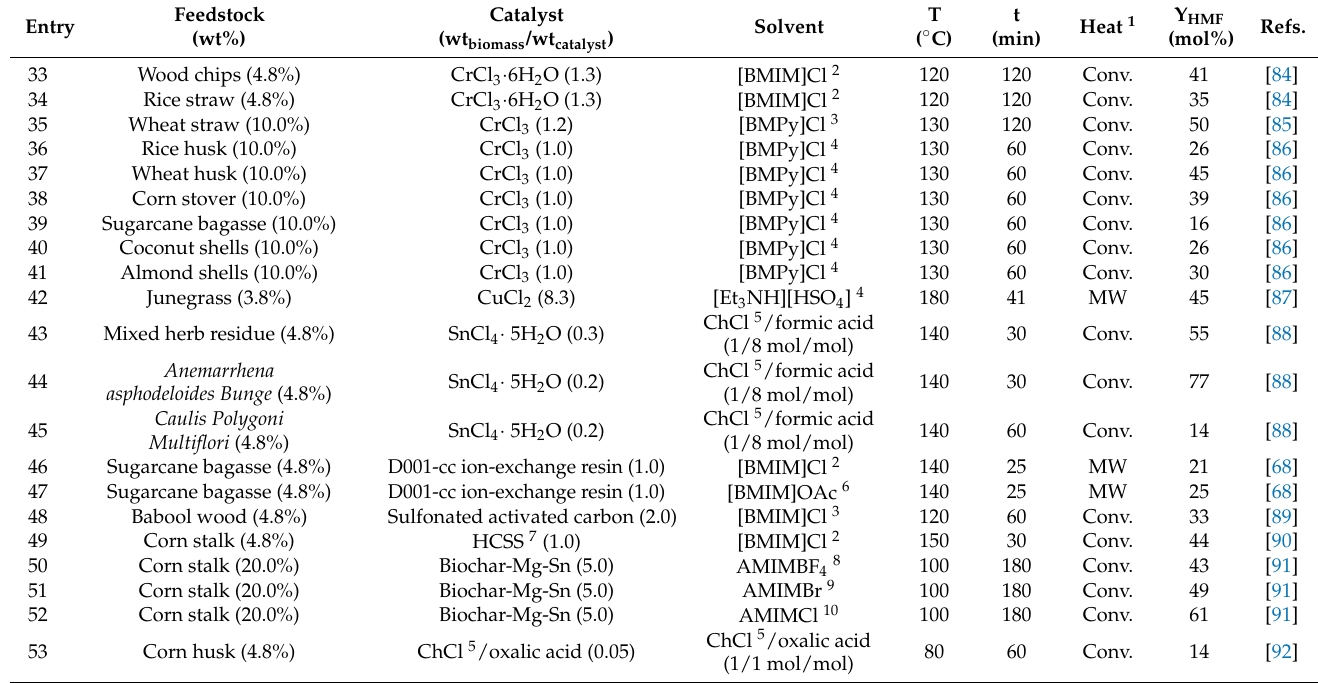
Table 2. HMF production from raw biomasses in ionic liquids and deep eutectic